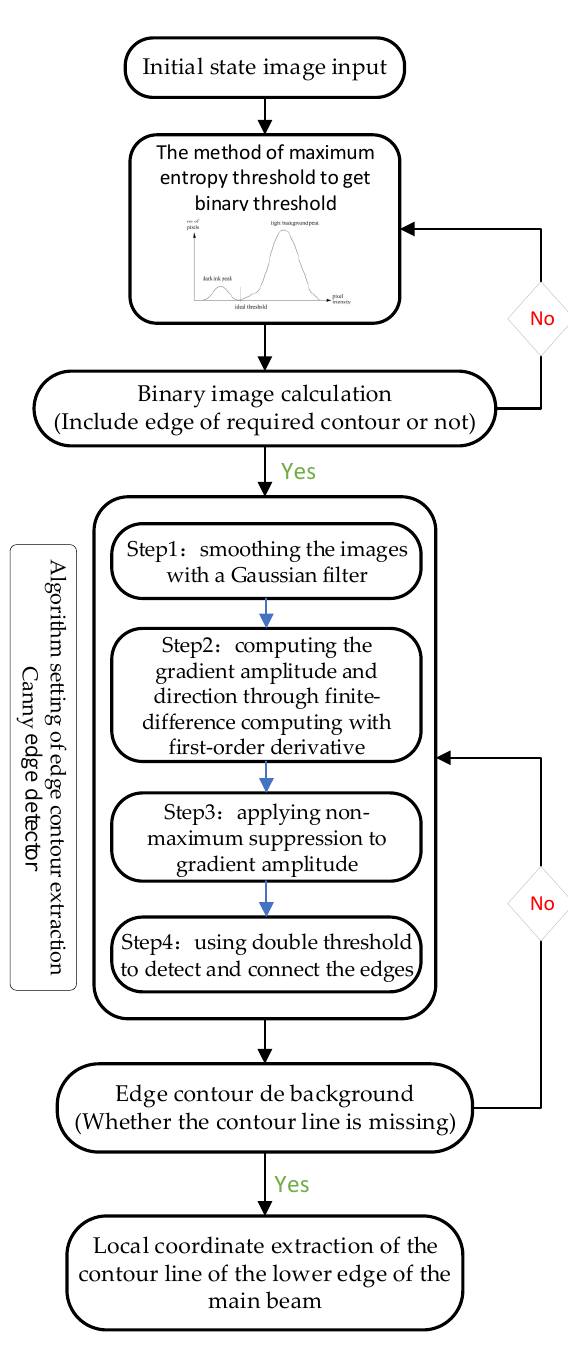
Figure 13. Flowchart of the MATLAB algorithm.